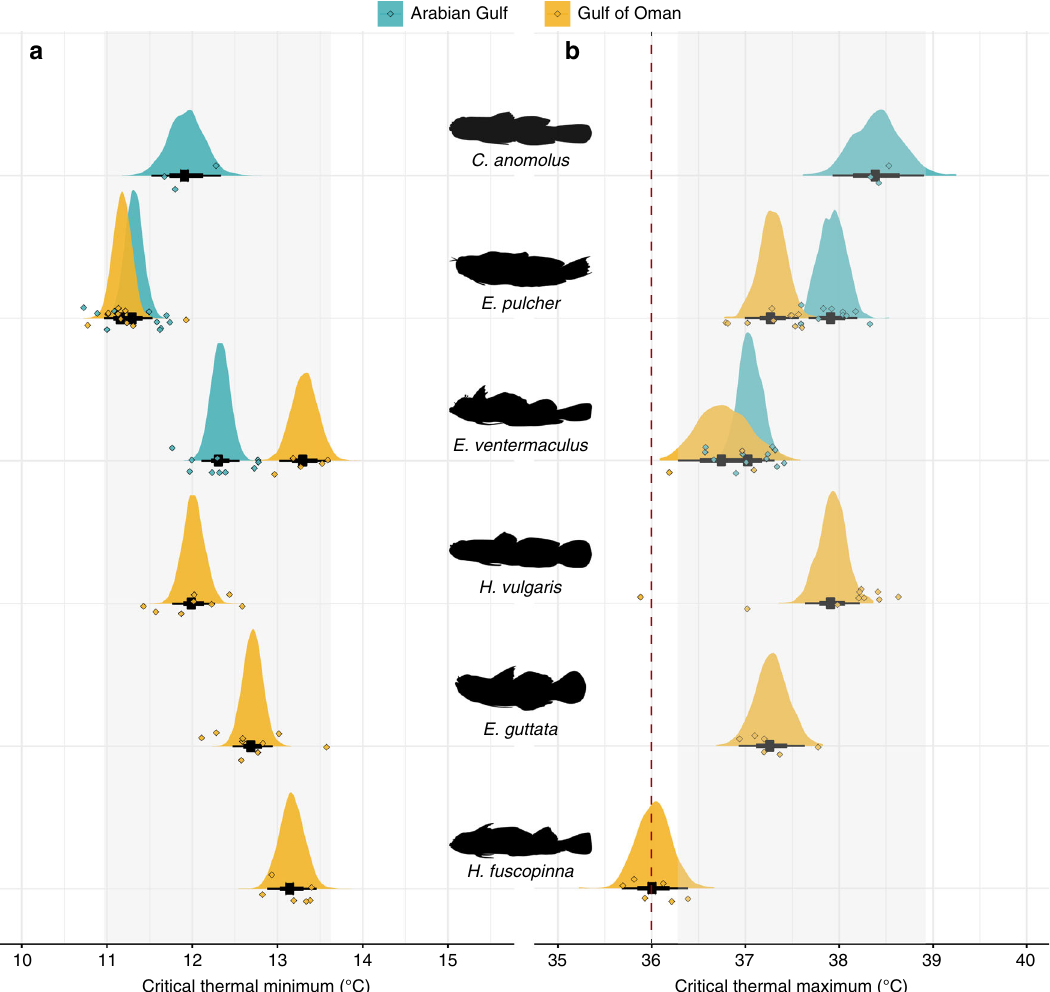
Fig. 3 Critical thermal tolerance limits of cryptobenthic fi sh species from the Arabian Gulf and Gulf of Oman. a Average critical thermal minima and b average critical thermal maxima. The red dashed line (36 °C) indicates the maximum temperature recorded in the Arabian Gulf. Density curves and black caterpillar plots (50 and 95% credible intervals) represent fi tted values from Bayesian linear models. Diamonds represent raw values, jittered on the y -axis. Gray boxes delineate the range of the 95% credible intervals obtained for the three species present in the Arabian